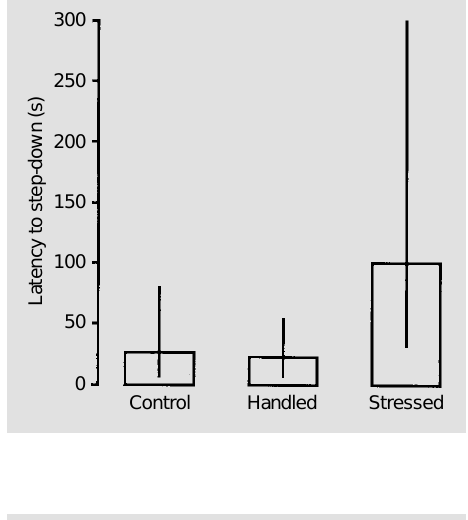
Figure 3 - Effect of chronic re- straint stress on performance in a two-way active avoidance